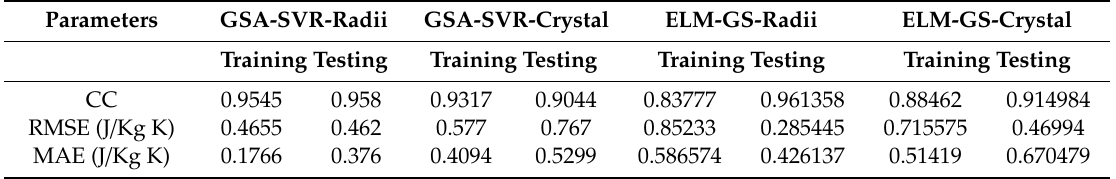
Figure 8. Comparison between the ELM-GS-radii and ELM-GS-crystal models on the basis of the root-mean-square error. Table 3. Performance measuring parameters for the four developed models at di ff erent stages of model